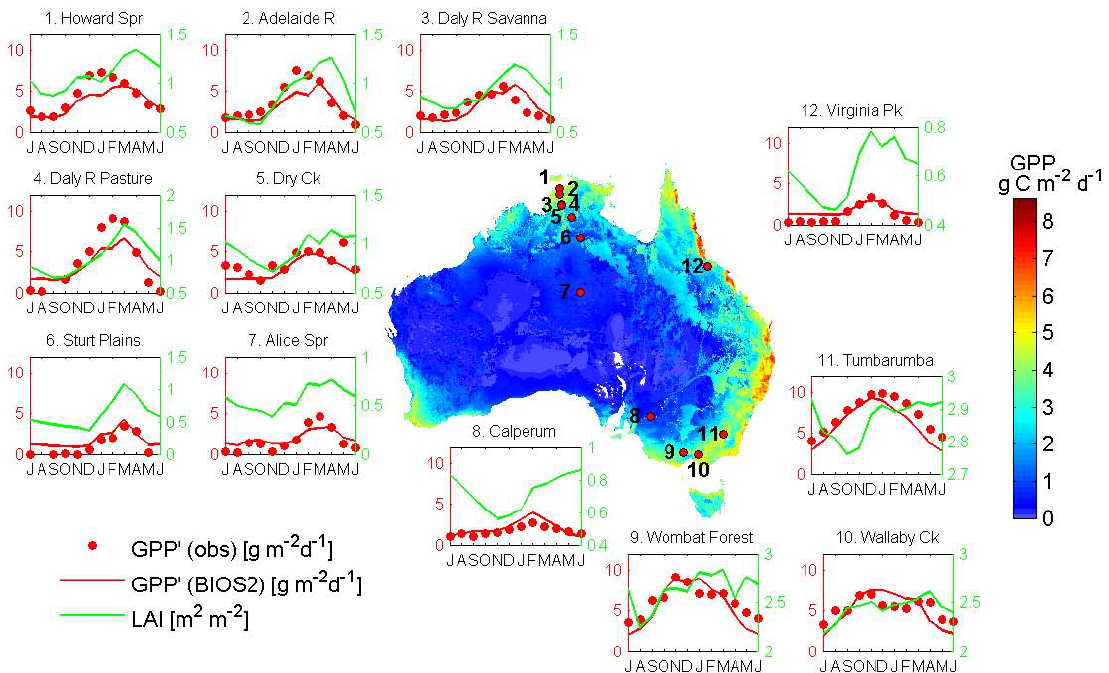
Fig. 6. Mean (1990–2011) GPP (map), mean annual cycle (averaged over years of obs) of GPP 0 (BIOS2 and obs, left axis) and LAI (right axis) at 12 OzFlux